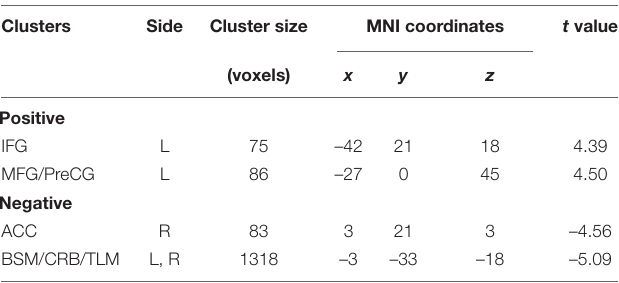
TABLE 1 | Clusters indicating correlations between DC and